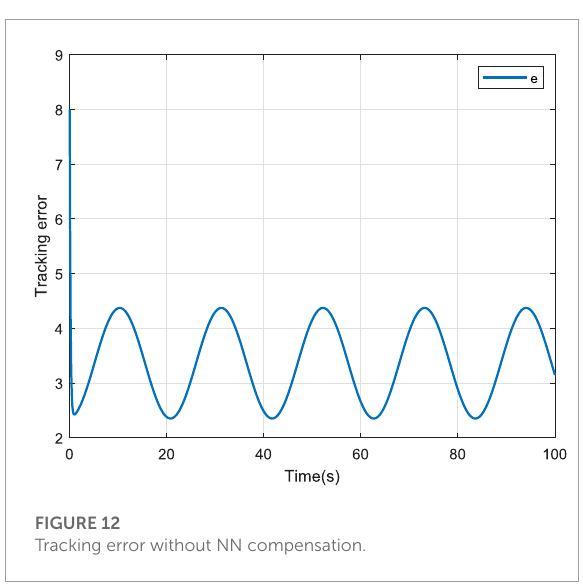
FIGURE 12 Tracking error without NN